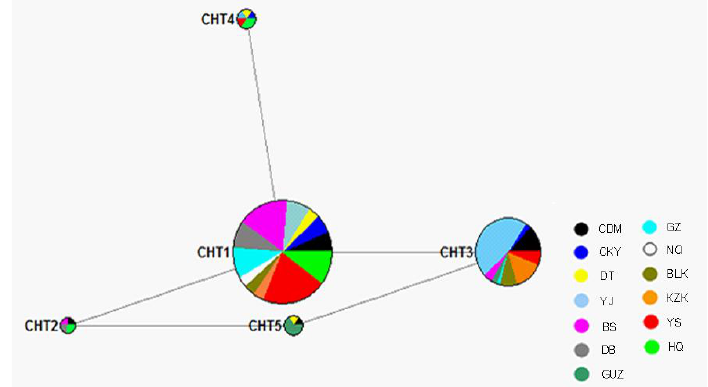
Figure 3. A Median-joining (MJ) network calculation of Chinese horse Y chromosome. Colored circles represent sequence haplotypes,, the area being proportional to the frequency of the haplotype in total samples. Branch length is proportional to number of mutations. Different colors represent different horse breed. The network clearly revealed that CHT1 was in the center position, which indicated CHT1 maybe an ancestral haplotype. CDM, Chaidamu; CKY, Chakouyi; DT, Datong; YJ, Yanji; BS, Baise; DB, Debao pony; GUZ, Guanzhong; GZ, Guizhou; NQ, Ningqiang; BLK, Balikun; KZK, Kazakh; YS, Yushu; HQ,